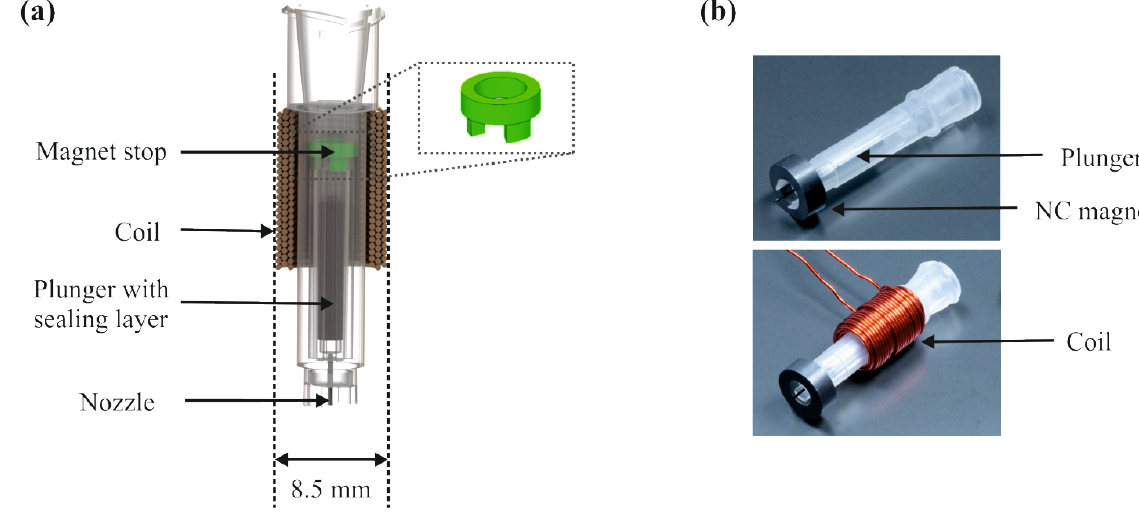
Figure 5. ( a ) CAD model of the one-part valve body with an insert molded polyimide nozzle. The plunger with a 1 mm thick silicone layer is inserted and the valve is closed with a stopper ( green ). ( b ) Photographs of the first samples of the injection molded, disposable, non-contact dispensing valve with and without